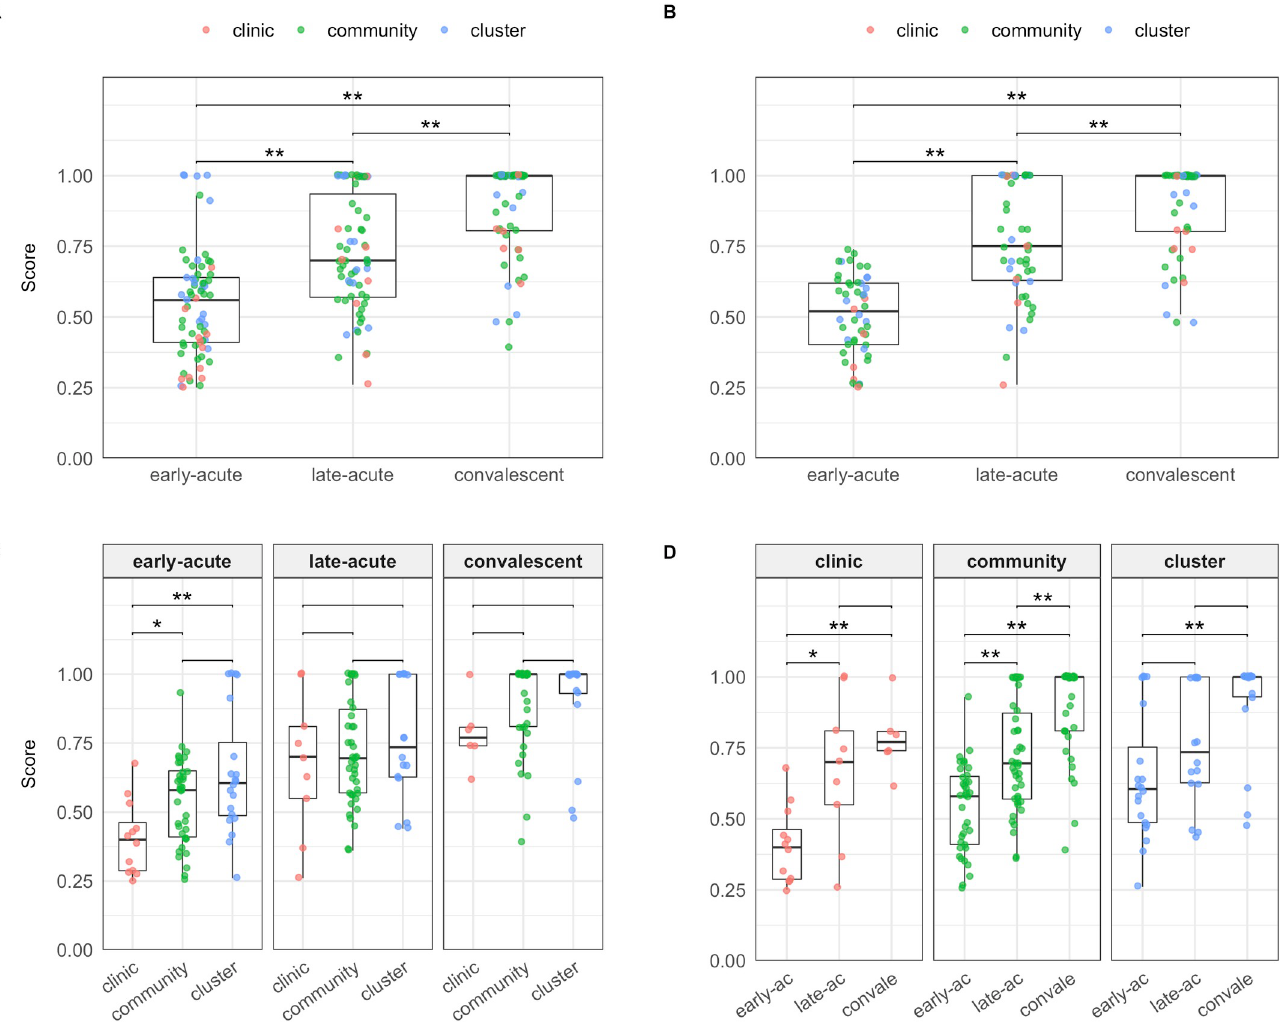
Fig 2. HRQoL score by illness phase Box and whisker plots demonstrate the distribution of HRQoL scores in each illness phase, dark horizontal line = median, upper limit of box = 75 th percentile, lower limit box = 25 th percentile, upper whisker extends to the largest value < = 1.5 multiplied x IQR, lower whisker extends to the smallest value > = 1.5 x IQR. Red dots represent individual scores. They are partially transparent and therefore appear darker where multiple points overlay each other. A : Un-paired analysis of all participants regardless of recruitment mode or the number of surveys completed, � Wilcoxon: P < 0 . 05 , �� Wilcoxon: P < 0 . 01 . B : Paired analysis of only participants who completed a single survey in each illness phase regardless of recruitment � Wilcoxon: P < 0 . 05 , �� Wilcoxon: P < 0 . 01 . C: Un-paired analysis comparing recruitment modes within each illness phase � Wilcoxon: P < 0 . 05 , �� Wilcoxon: P < 0 . 01 . D : Un- paired analysis comparing illness phases within each recruitment mode � Wilcoxon: P < 0 . 05 , �� Wilcoxon: P < 0 . 01 . Paired versions of C & D can be seen in S6